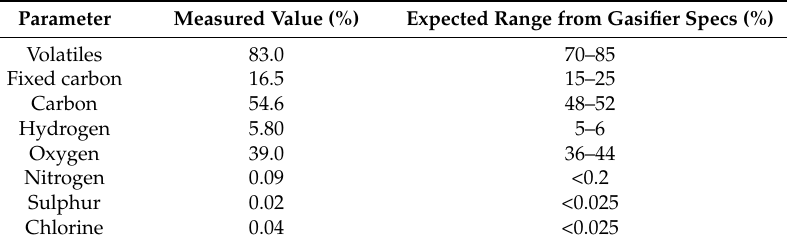
Table 2. Ultimate and proximate analysis of fuel.